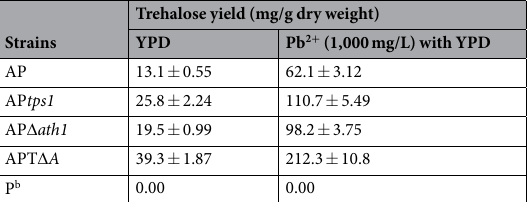
Table 2. Intracellular trehalose levels of A. subglaciale F134 wild-type and trehalose biosynthesis mutants under different conditions a . a Strains were precultured in YPD medium to stationary-phase, and cells were collected and cultured in YPD with or without the stress factors at 28 °C with 200 rpm for 10 h. All data shown are mean values from at least three replicate experiments. b P < 0.05 indicates there are statistically significant differences between the four strains.